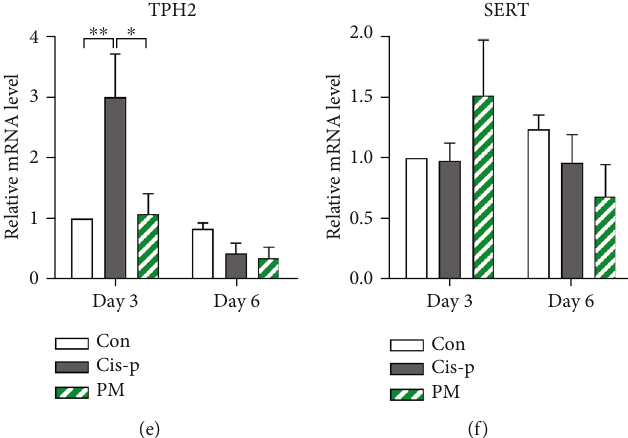
Figure 3: E ff ects of probiotic mixture on cisplatin-induced colonic 5-HT biosynthesis in rats. (a) Representative images of colons with chromogranin A (gastrointestinal endocrine cell marker, green) and 5-HT (red) staining. Levels of colonic (b) and serum (c) 5-HT. Colonic expression of TPH1 (d), TPH2 (e), and SERT (f) relative to β -actin. Data are normalized to expression levels in the control rats on day 3. Data are expressed as mean ± SEM ( n = 4 -5): ∗ p < 0 : 05 and ∗∗ p < 0 : 01